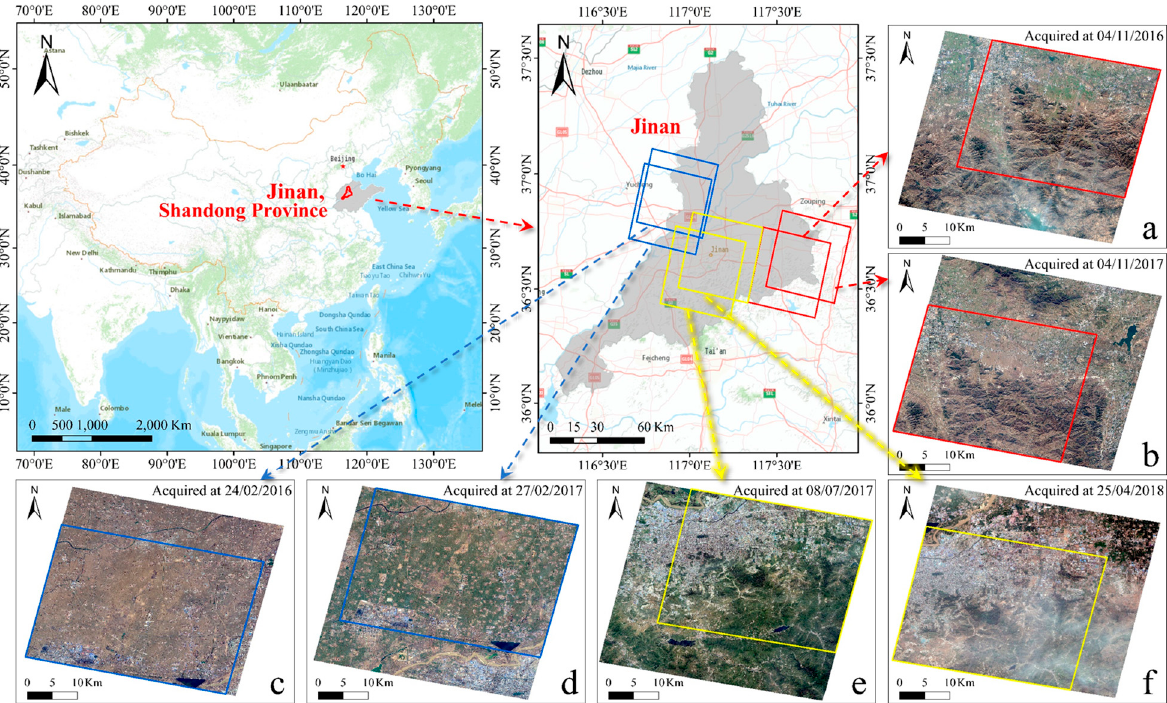
Figure 3. The experimental area and GF1 bi-temporal remote sensing images with ture-color (R: Band3, G: Band2 B: Band1). The red polygon of ( a , b ), blue polygon of ( c , d ), and yellow polygon of ( e , f ) are the common areas of bi-temporal images for each group.